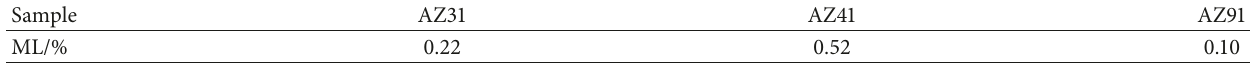
Table 4: Mass loss percentages of sample AZ31, AZ41, and AZ91.